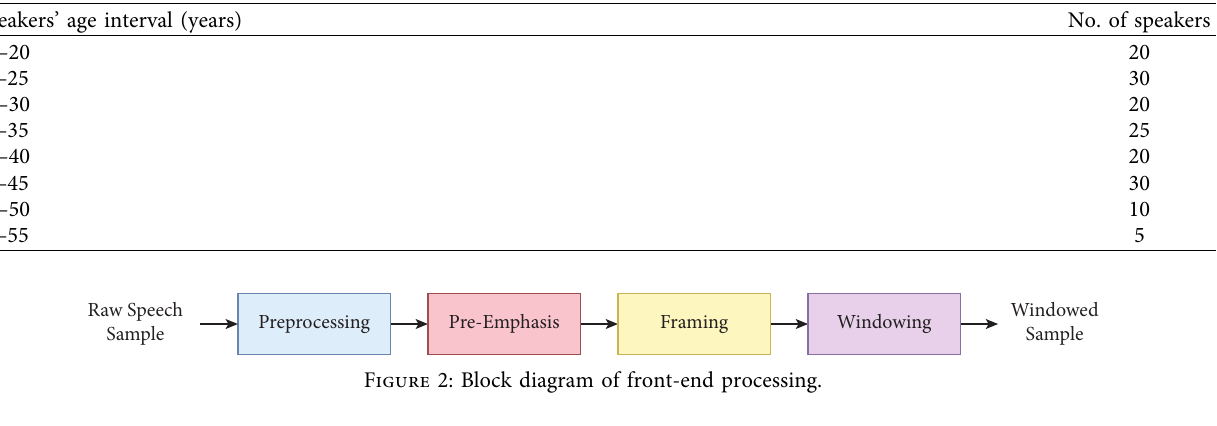
Table 4: Selected dialects with their respective regions of